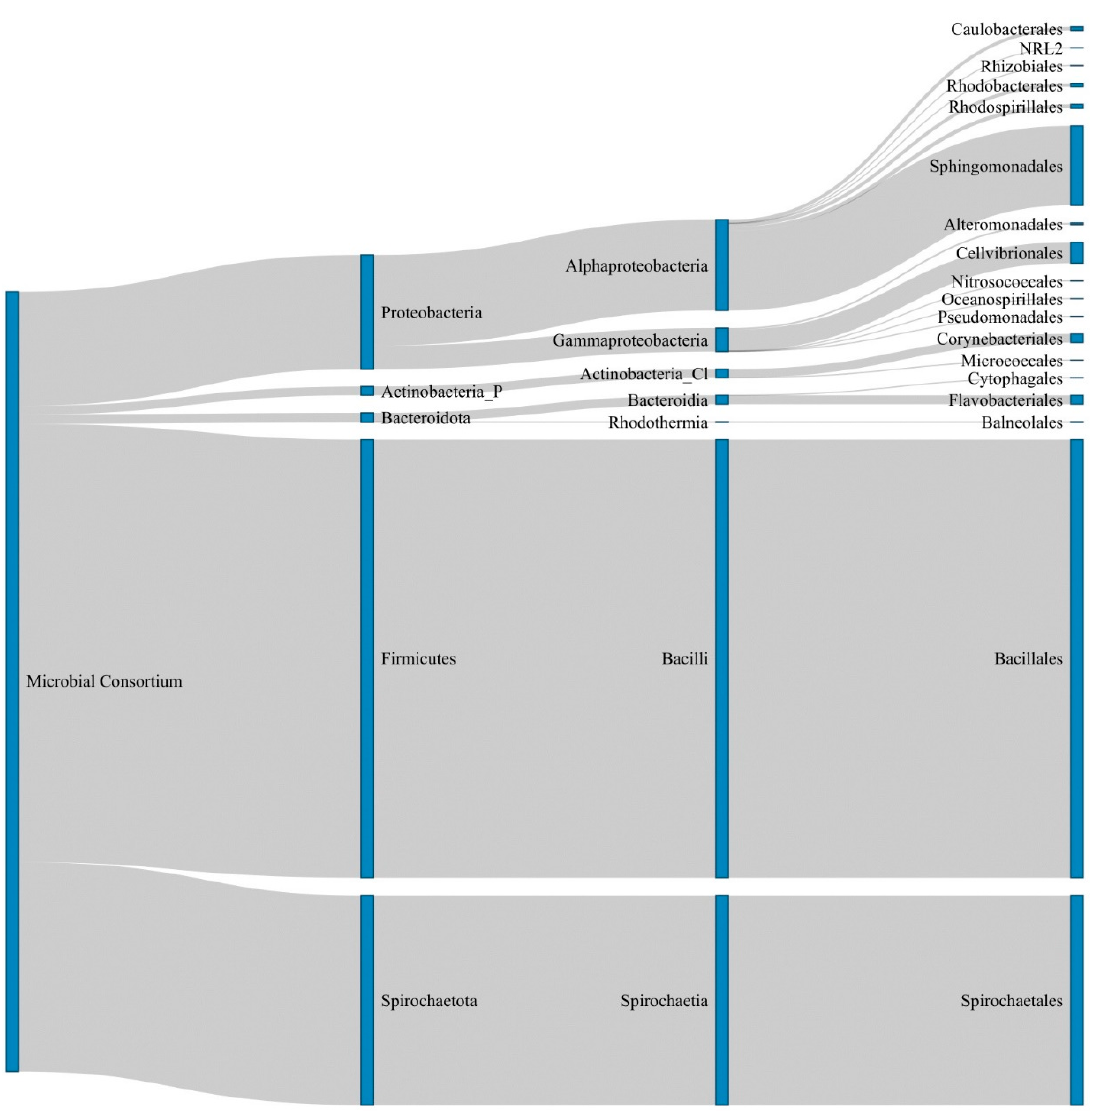
Figure 4. Sankey diagram representing the composition of T. lutea -associated microbial consortium (xenic-B 12 ) estimated by metabarcoding. From left to right are the relative proportions of taxa at the phylum, class and order levels for one of three replicates (see Supplementary Table S2A for details on the other replicates) using the ASVs assigned starting at the phylum level. Actinobacteria_P: phylum Actinobacteria; Actinobacteria_Cl: class Actinobacteria.